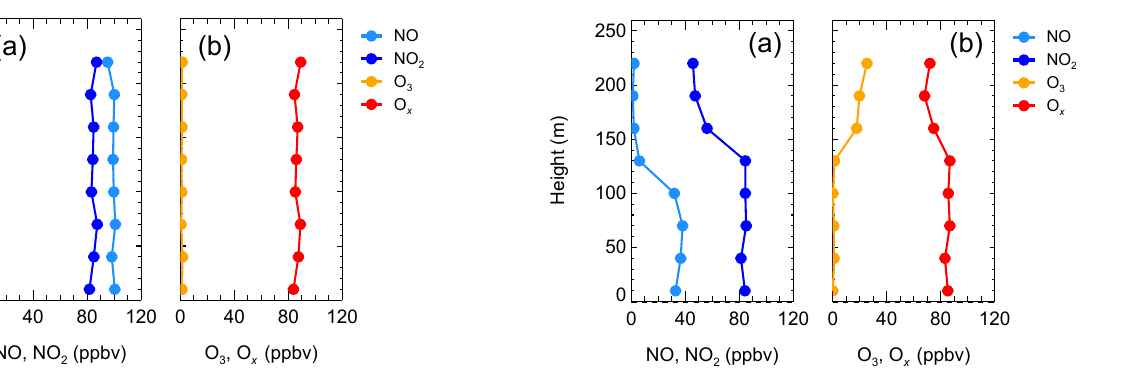
Figure 4. O x missing case presented by the vertical profiles of (a) NO and NO 2 and of (b) O 3 and O x at 20:38–21:13 on the night of 19 December